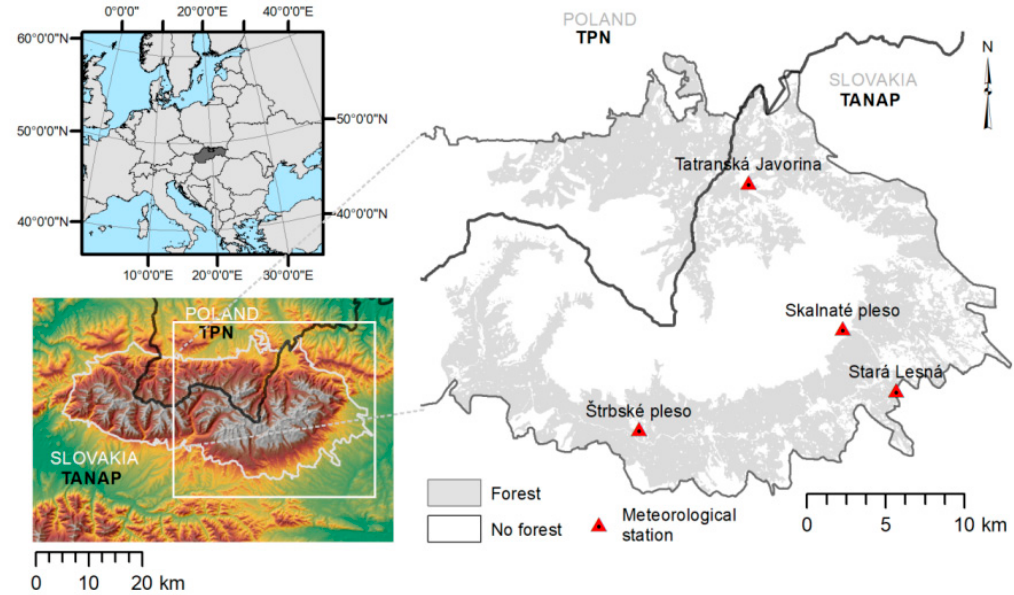
Figure 2. Location of the study area in the High Tatra Mountains. Grey represents the area of forest cover under our investigation; red triangles represent meteorological stations.